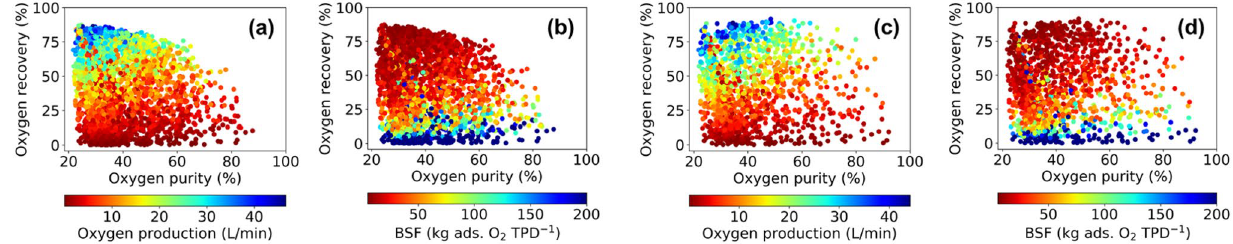
Figure 5. Process simulation data and output performance metrics for LiX zeolite. ( a , b ) PSA cycle and ( c , d ) PVSA cycle.